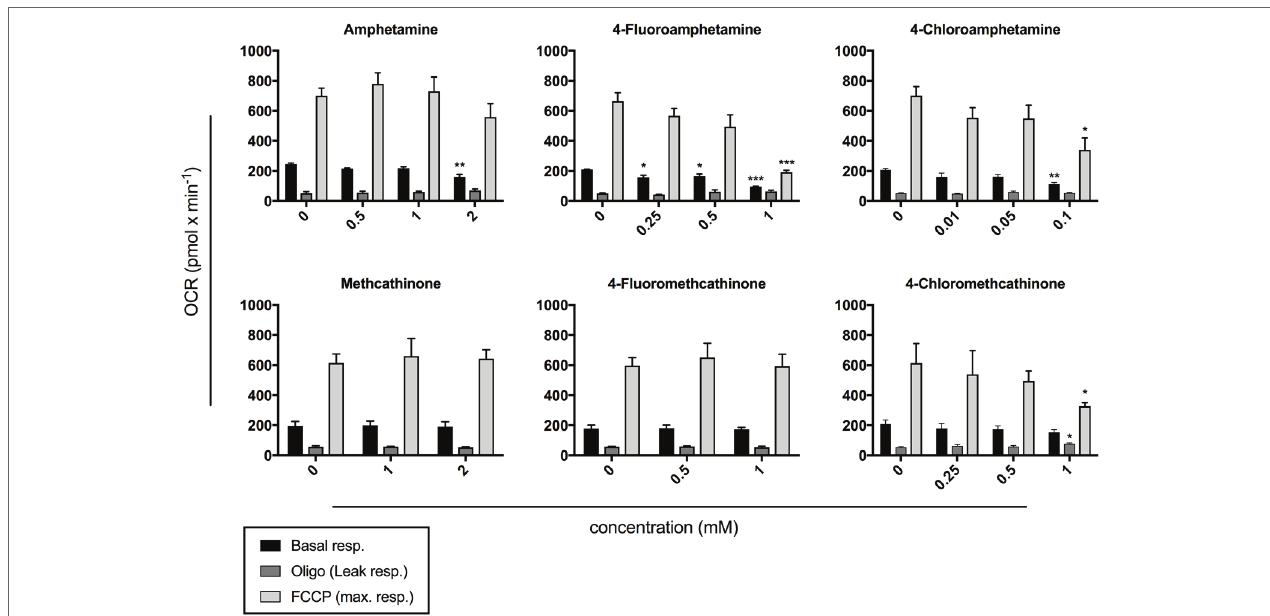
FIGURE 4 | Oxygen consumption rate (OCR) in HepG2 cells after drug exposure for 24 h. Basal respiration, leak respiration, and maximal respiration are expressed as mean ± SEM adjusted to protein content. Numbers in parentheses indicate the number of individual experiments performed in triplicate: amphetamine (3), 4-fluoroamphetamine (3), 4-chloroamphetamine (5), methcathinone (5), 4-fluoromethcathinone (5), and 4-chloromethcathinone (4). Significance levels are given as * p < 0.05, ** p < 0.01, *** p <